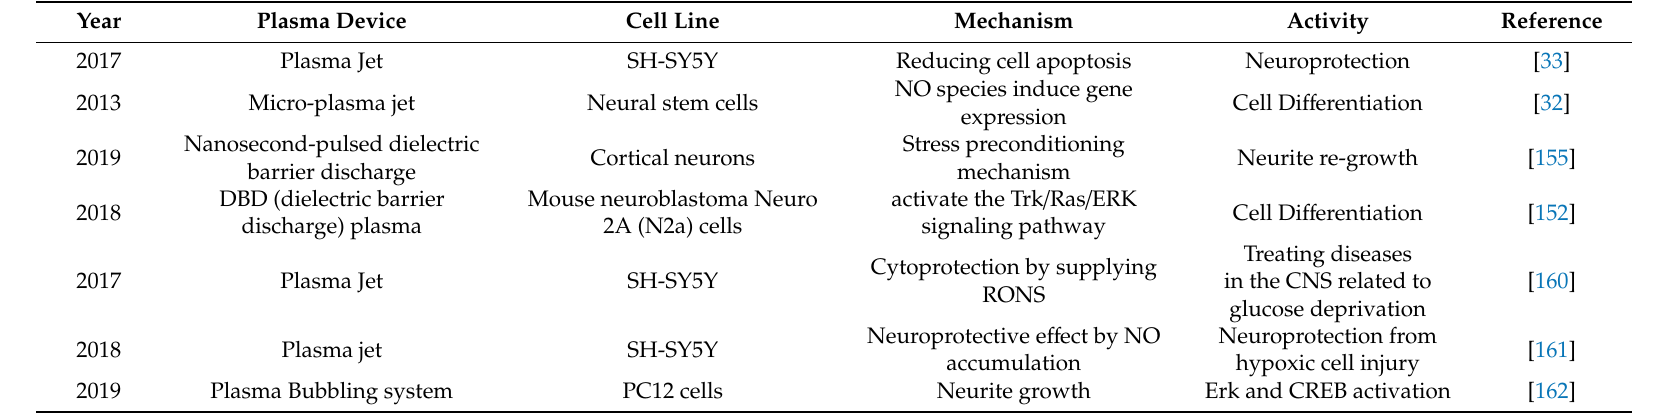
Table 2. Non-thermal plasma application for neuronal